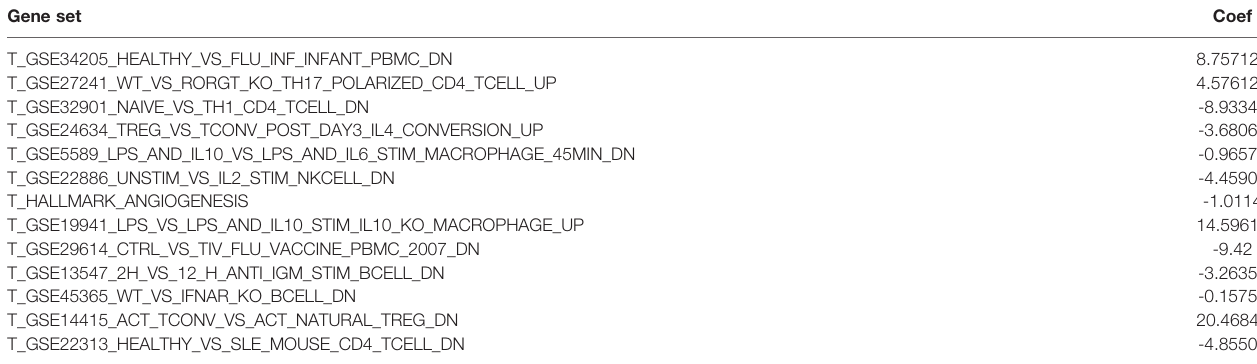
TABLE 1 | Results of LASSO analysis regarding 13 gene sets affecting the survival prognosis of glioma patients. Gene